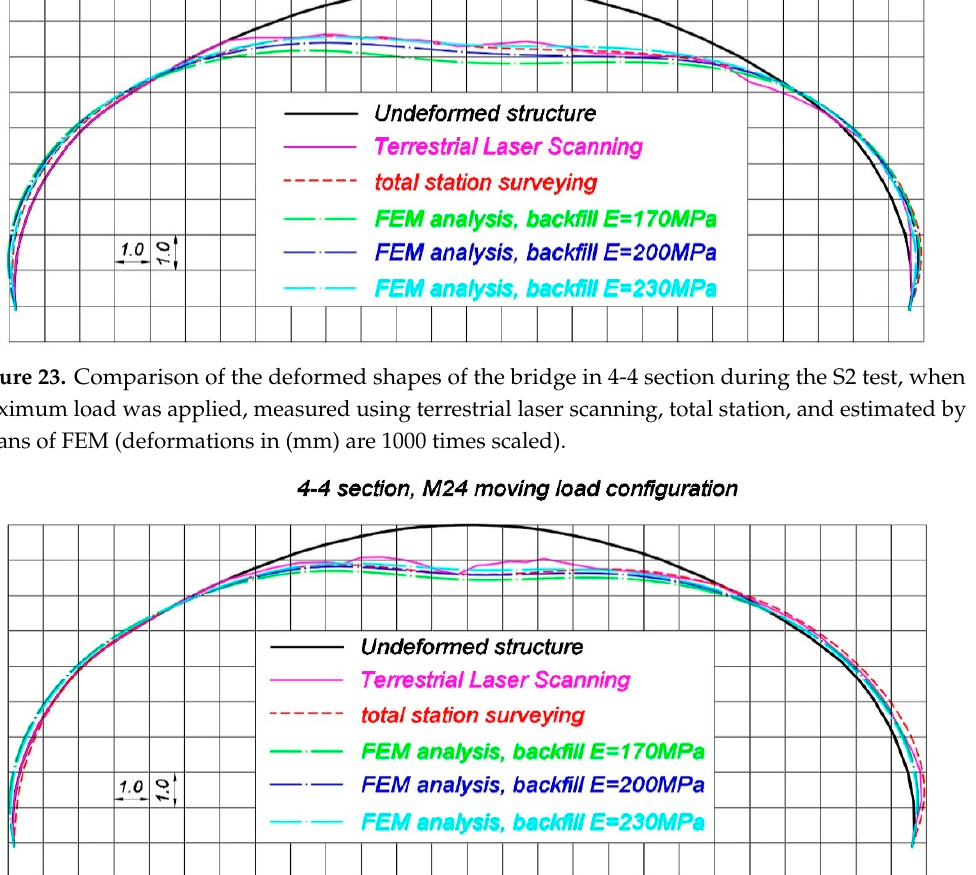
Table 3. Comparison of the in situ measured and estimated by means of FEM extreme displacements.